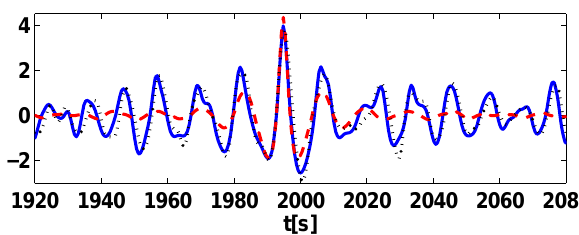
Fig. 17. The density plot of the variance of the total wave phase for IW12.